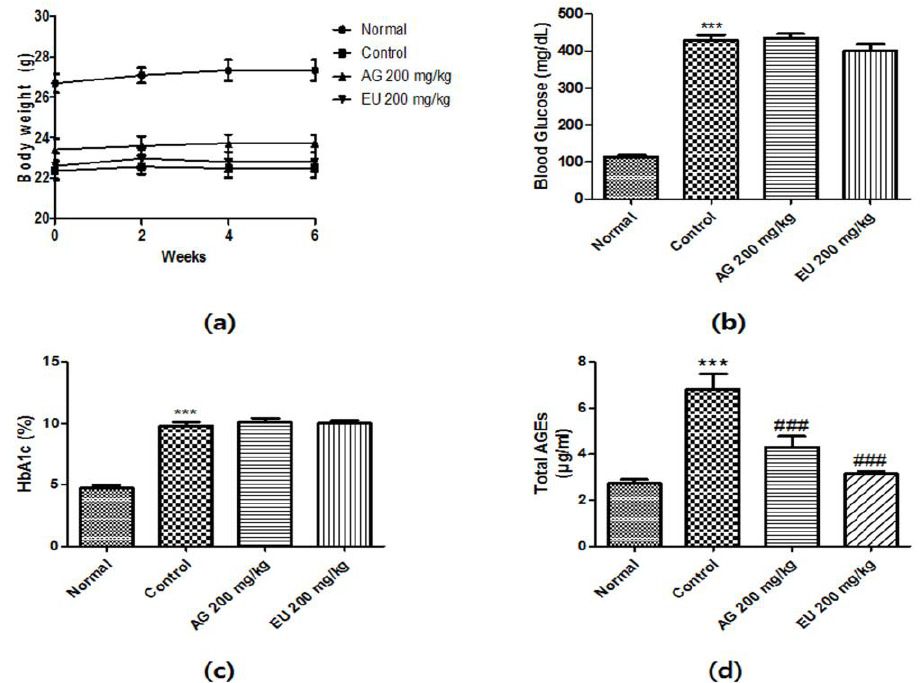
Figure 3. Diabetic parameters of streptozotocin (STZ)-induced diabetic mice. ( a ) Time course of body weight changes of mice; ( b ) Fasting blood glucose levels of normal and STZ-induced diabetic mice following a 6-week treatment and after 12 h of fasting; ( c ) Glycated hemoglobin (HbA1c) levels of normal and STZ-induced diabetic mice after a 6-week treatment; ( d ) Serum advanced glycation end-product (AGE) levels of normal and STZ-induced diabetic mice after a 6-week treatment and 12 h fast. Value are means ± standard error of the mean (SEM, *** p < 0.001 vs. normal and ### p < 0.001 vs. control).